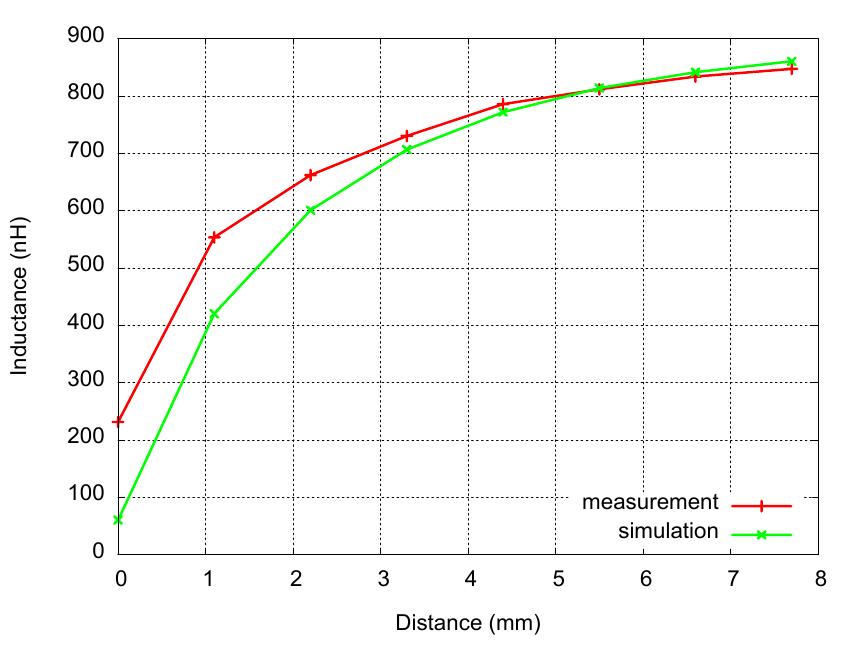
Figure 10. Inductance as function of a distance from conductive target: measured and simulated values.